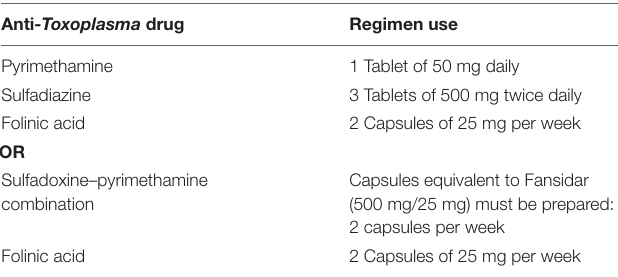
TABLE 3 | Pyrimethamine–sulfonamides combinations for